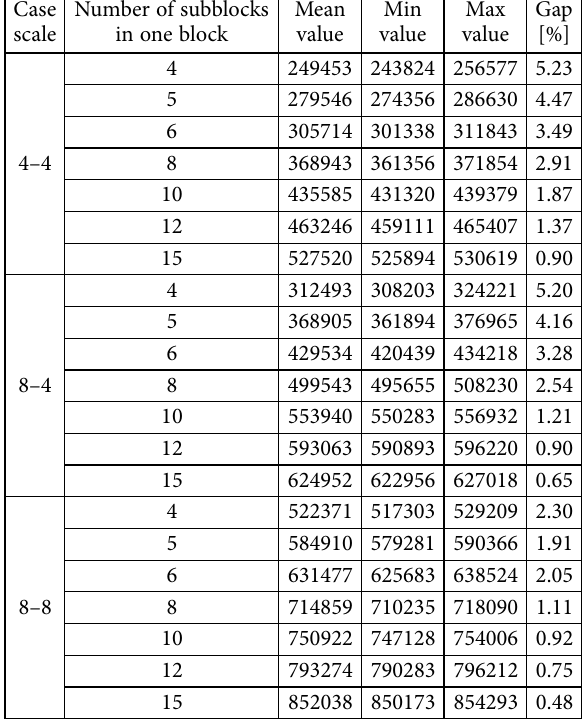
Table 6. Results of cases with different yard